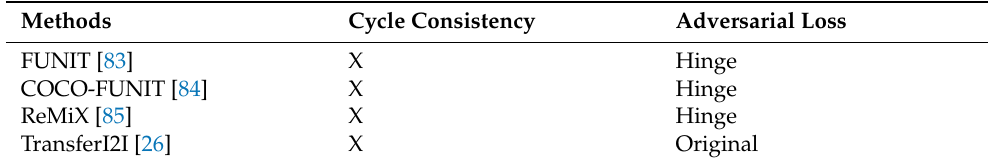
Table 6. Comparison between papers in the Data Issue category (Section 7). The comparison is based on the cycle consistency and the adversarial loss used. “V” and “X” means that the method use the technique in the columns is “used” and “not used” respectively. “-” indicates that the corresponding information was not